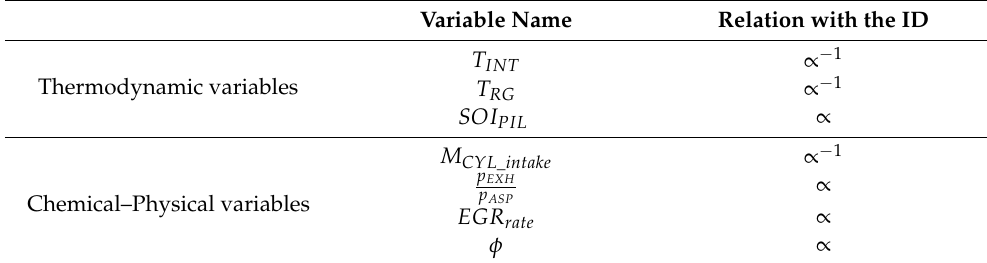
Table 7. Effects of both thermodynamic and chemical–physical variables on the ignition delay. Variable